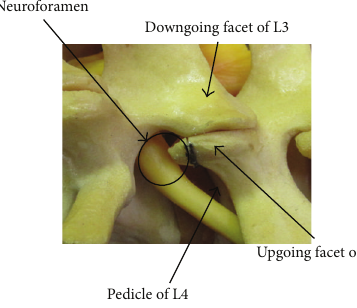
Figure 1: Sawbones representation of lumbar spinal anatomy. The borders of the foraminal space can be identified.